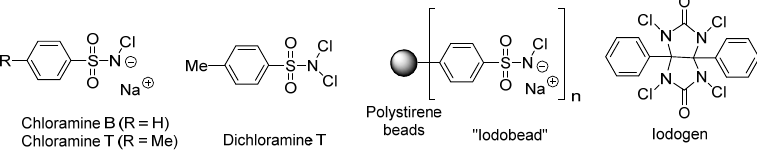
Figure 1. Typical oxidizing agents used in electrophilic iodination.